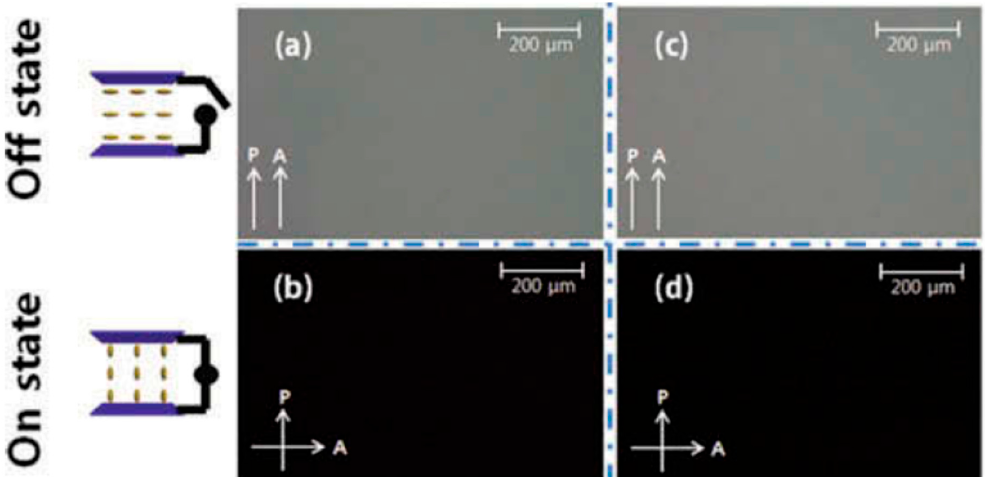
Figure 7. Polarized optical microscope (POM) images of a conventional nematic cell and a cell with the doped QD-nematic liquid crystal (NLC) composite. The images ( a ) off state and ( b ) on state correspond to pure nematic whereas ( c ) off state and ( d ) on state to the QDs doped nematic [13]. Singh et al. [15] dispersed CdSe-QDs (size ∼ 3.5 nm) into NLC 4-pentylphenyl 4-octyloxybenzoate(4PP4OB) and studied the impact of QDs dispersion (0.01 wt%) on the